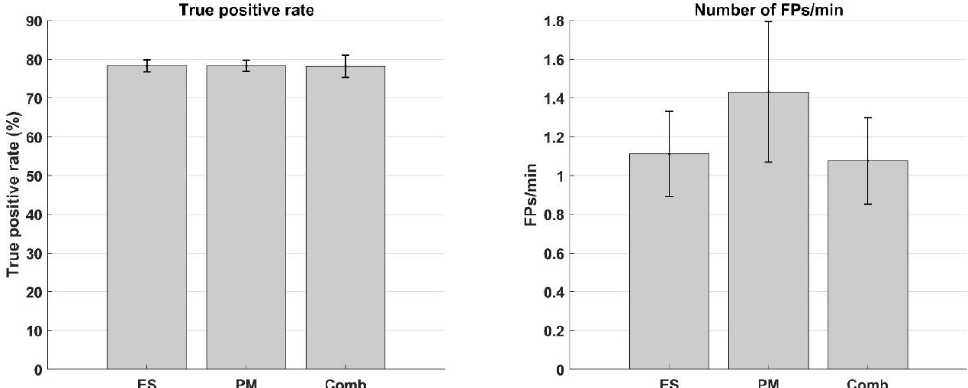
Figure 2. ( Left ) True positive rate (mean ± standard error) across all subjects. ( Right ) Number of false positive detections per minute (mean ± standard error) across all subjects. ‘ES’: Electrical stimulation, ‘PM’: Passive movement, and ‘Comb’: Combined electrical stimulation and passive movement.